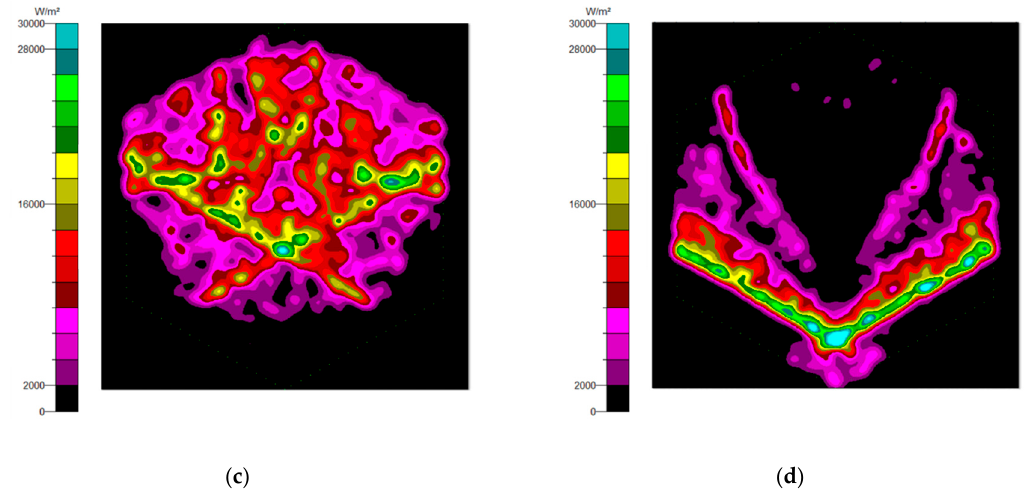
Figure 15. The irradiance distribution of the solid-NACPC with misalignment angles of ( a ) 0°, ( b ) 10°, ( c ) 20°, and ( d ) 30°.